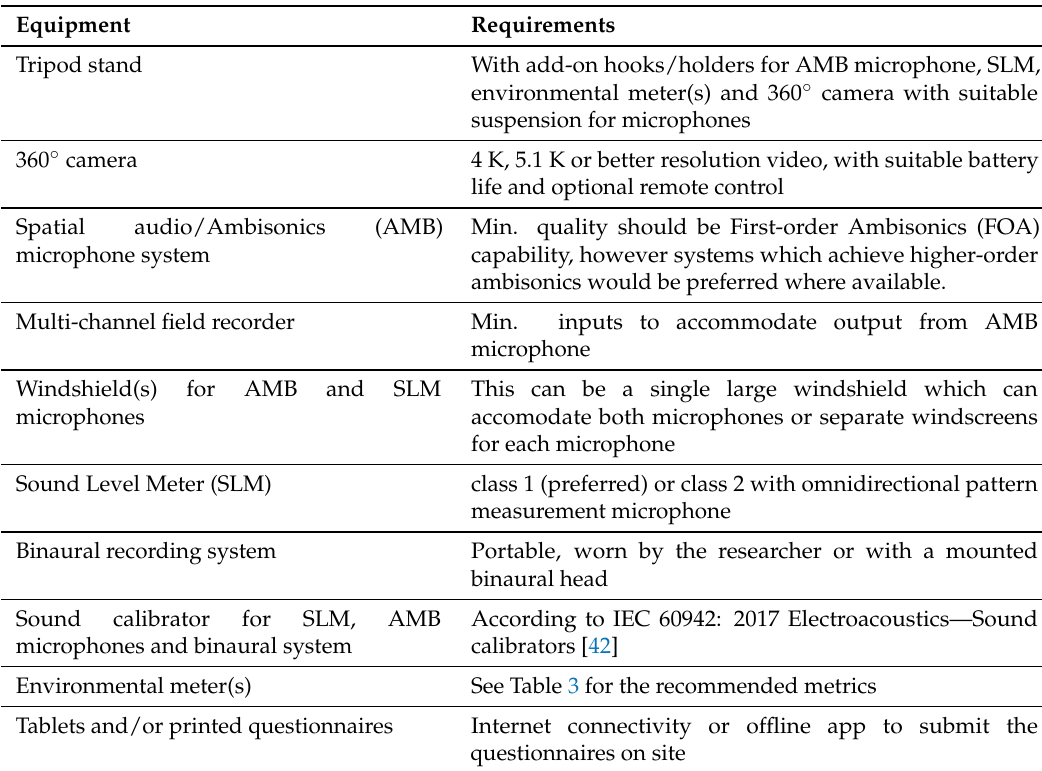
Table 2. Recommended equipment for implementing the SSID protocol. SLM: Sound Level Meter; AMB: Ambisonics; BIN: Binaural; QUE: